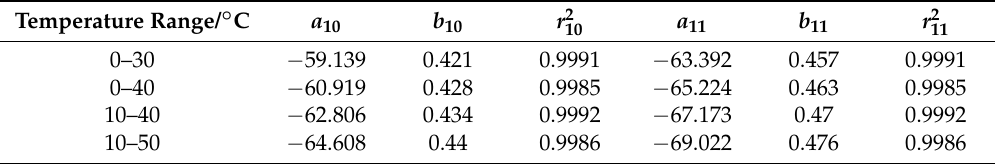
Table 2. Inversion regression coefficients of TIRS in different temperature ranges ( r 2 determinants of the fit).